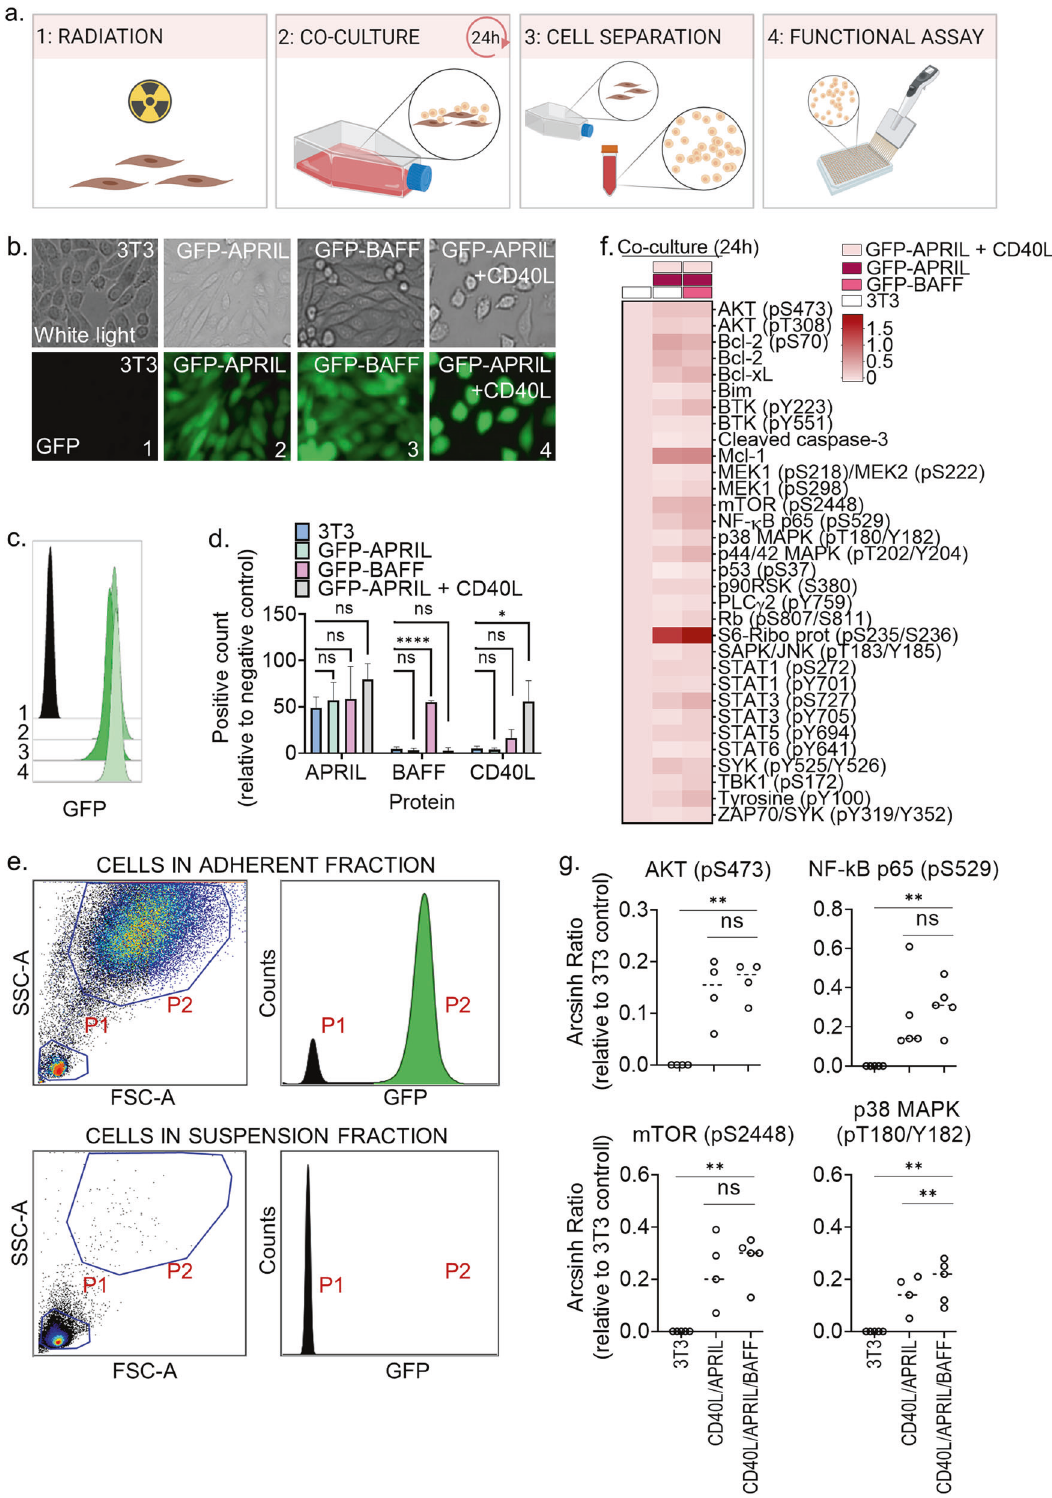
(Fig. 2j, k). These fi ndings support the notion that microenviron- mental factors contribute to drug resistance in CLL